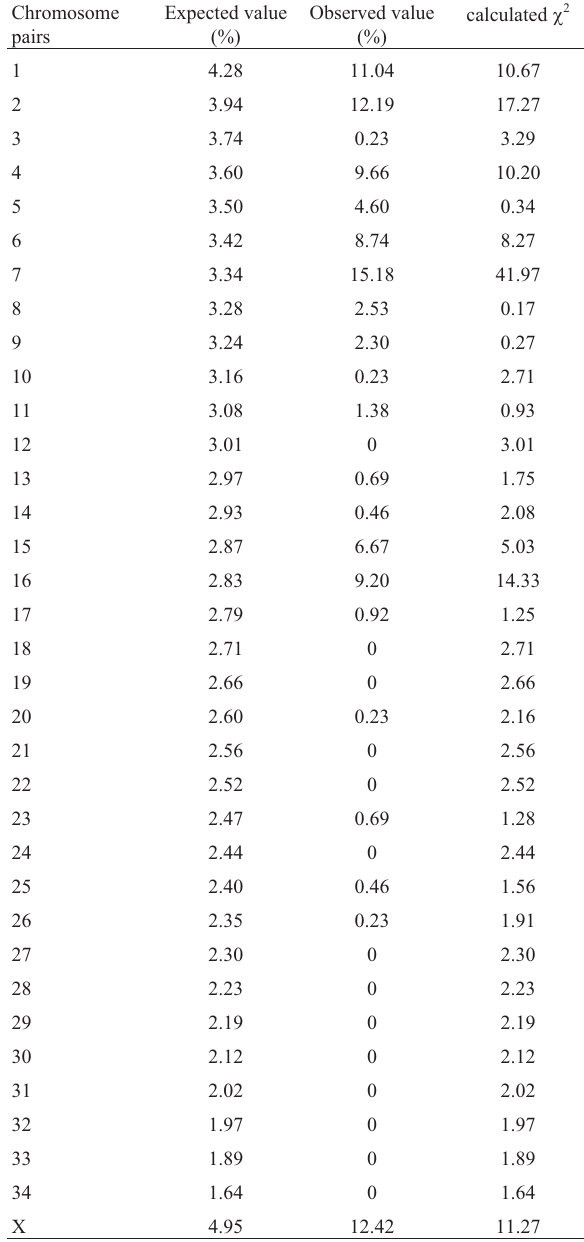
Table 2 - Values of the probability of each chromosome pair carrying chromosomal aberrations. Chromosome